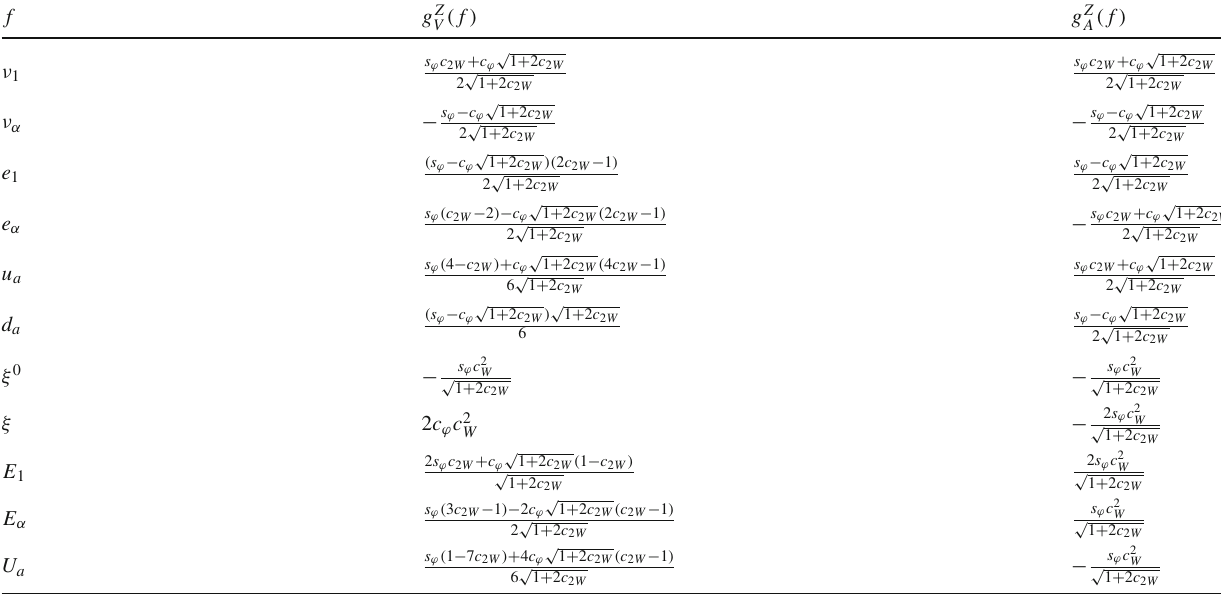
Table 2 The couplings of Z with fermions ( f (cid:19)= ν R ), whereas those for Z (cid:10) are obtained by replacement: c ϕ → s ϕ and s ϕ → − c ϕ